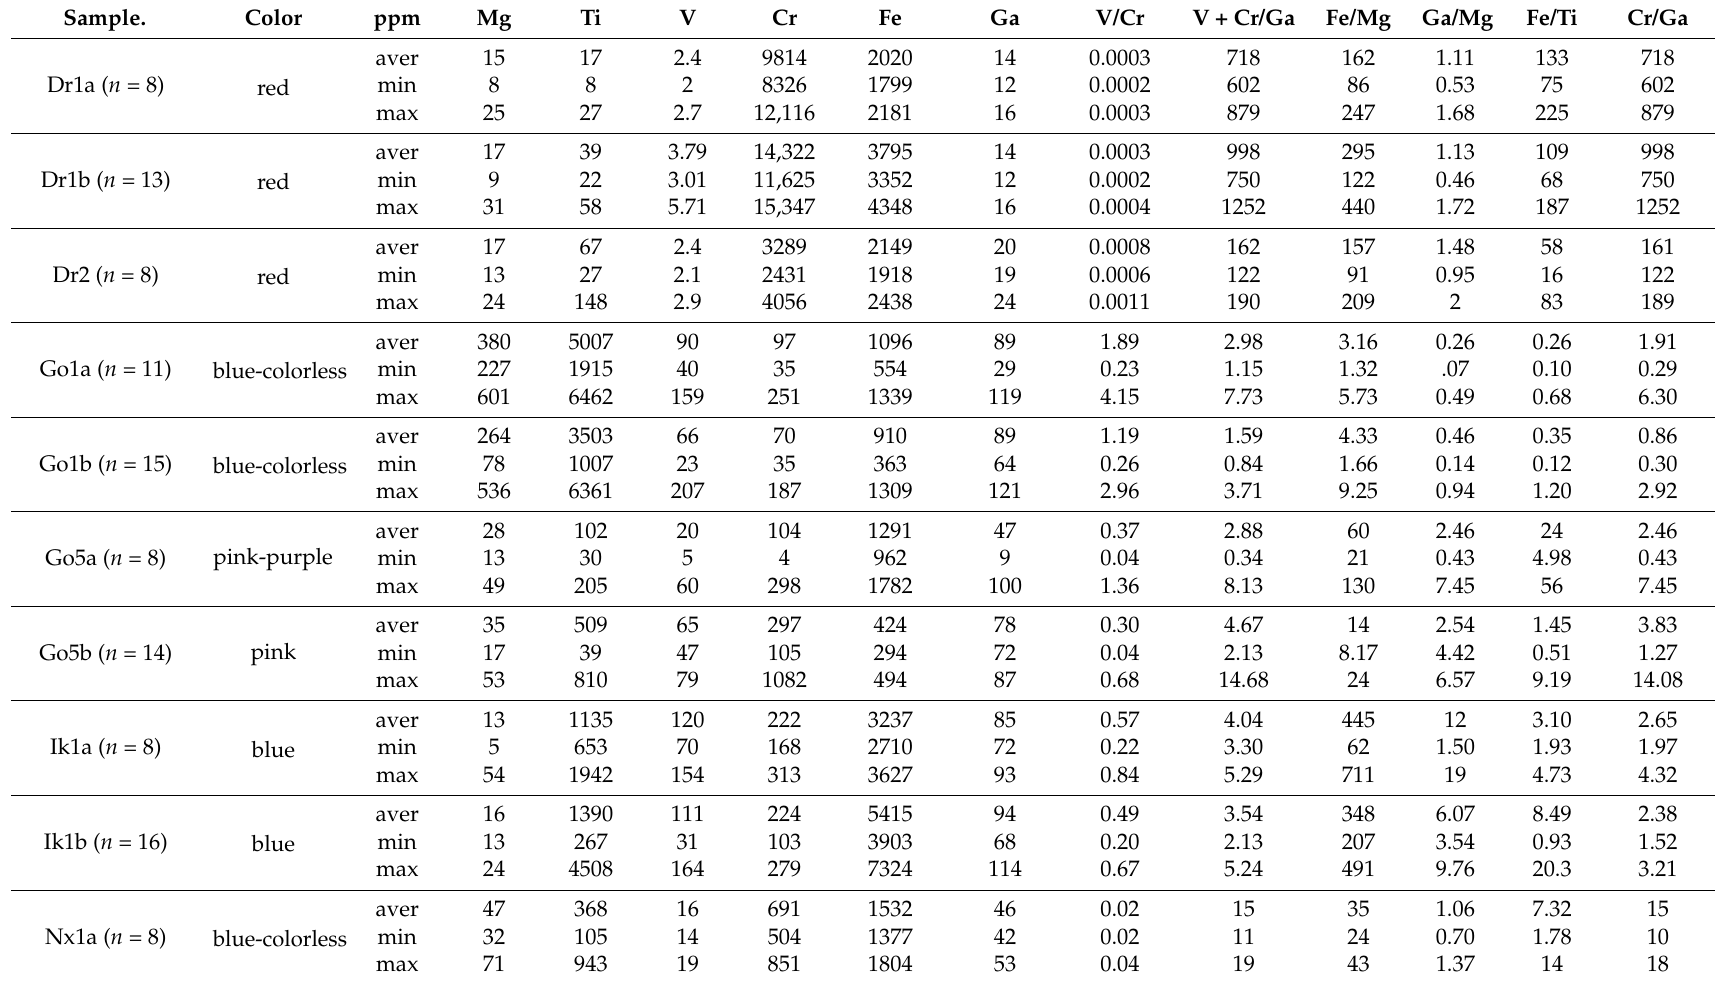
Table 3. Chromophores and key trace elements (Mg and Fe) LA-ICP-MS analyses (ppm) of the Greek corundum crystals and their different chemical ratios.